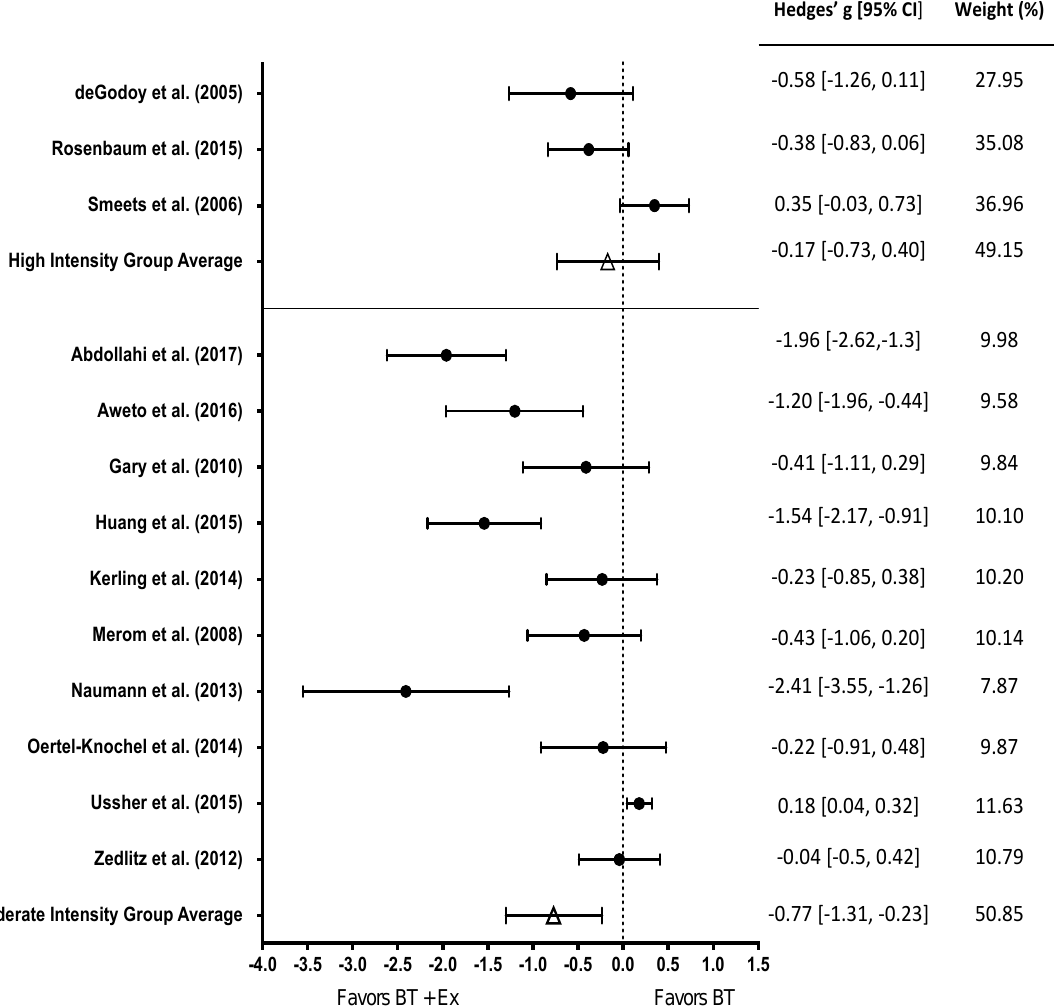
Figure 3. Subgroup analysis of BT + high intensity (top) and BT + moderate intensity exercise (bottom) among studies that measured depression. Test for overall effect of high intensity g = −0.17, p > 0.05. Test for overall effect of moderate intensity g = −0.77, p < 0.01. BT+Ex = Behavioral Therapy + Exercise, BT = Behavioral Therapy only.